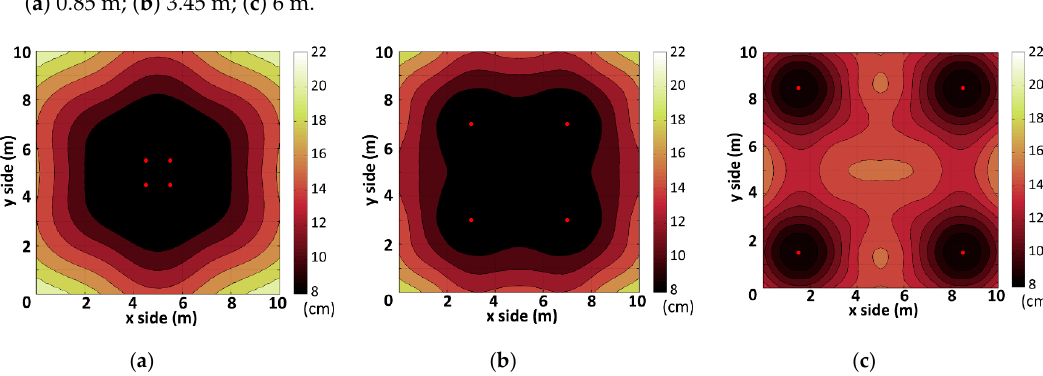
Figure 7. CRB evaluation for rectangular mesh at different edge sizes: ( a ) 1 m; ( b ) 4 m; ( c ) 7 m.